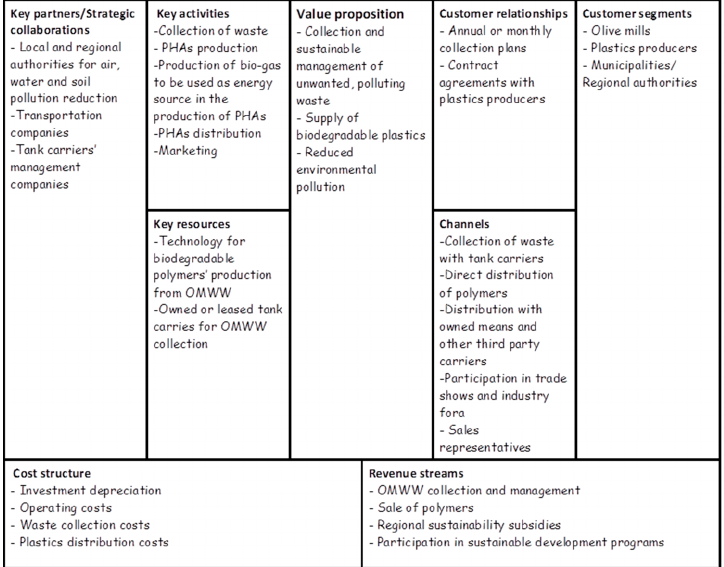
Figure 4. The Business Model Canvas of the planned biorefinery.